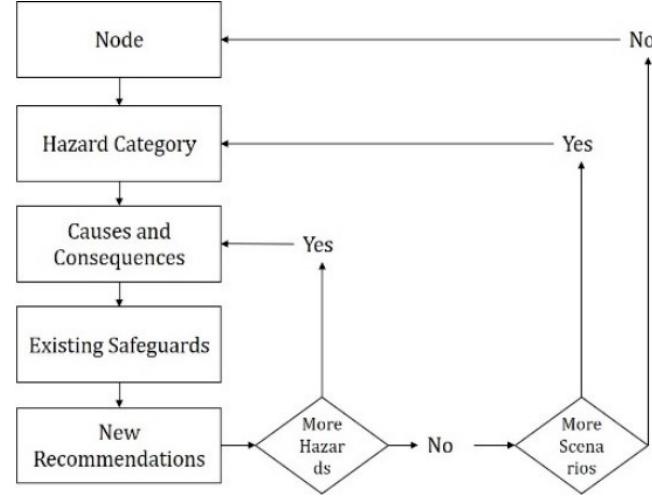
Figure 2. HAZID methodology.